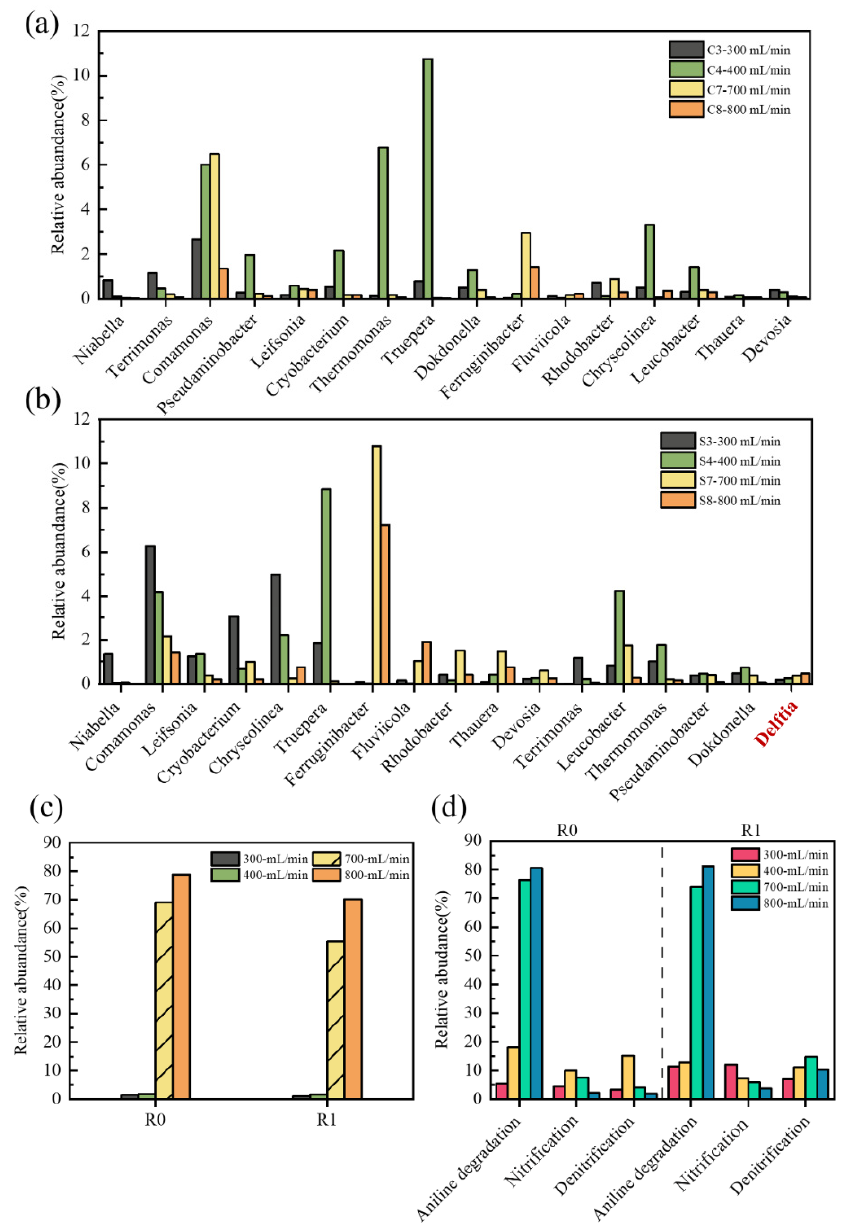
Figure 6. The distribution of functional microfloras. Phylogenetic classification of key functional groups in R0 ( a ) and R1 ( b ); the relative abundance of Acidovorax in R0 and R1 ( c ); the relative abundance of key functional groups in R0 and R1 ( d ).